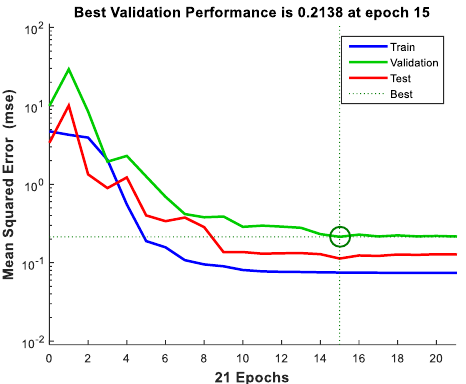
Figure 5. Evolution of the error in approximation of experimental data, during the learning process.